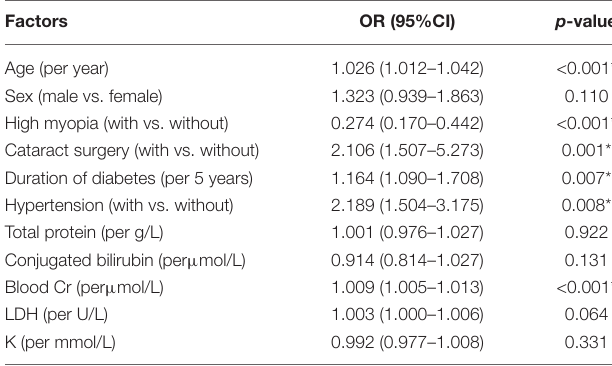
TABLE 2 | Multivariate Binary logistic regression analysis for risk factors of